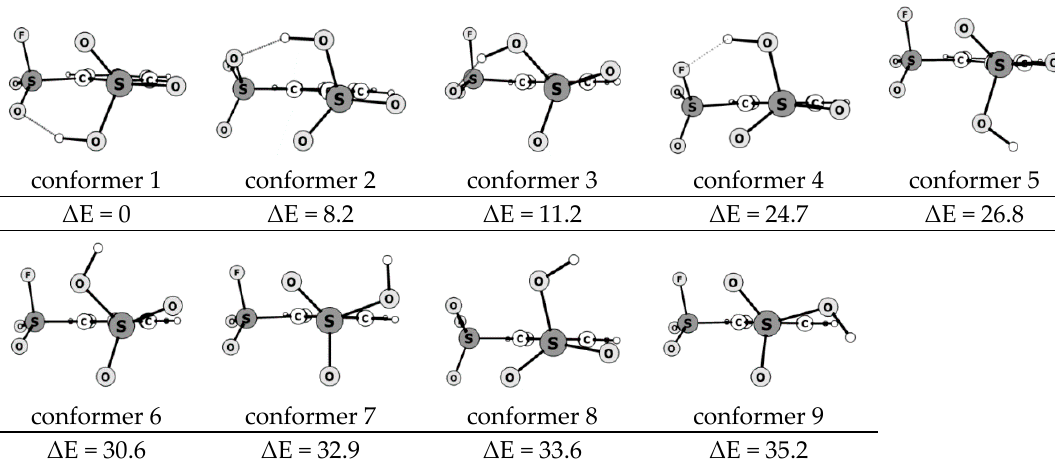
Figure 3. The structure of the 2-SO 2 F-BSAconformers and their relative energies ( Δ E, kJ mol − 1 ).